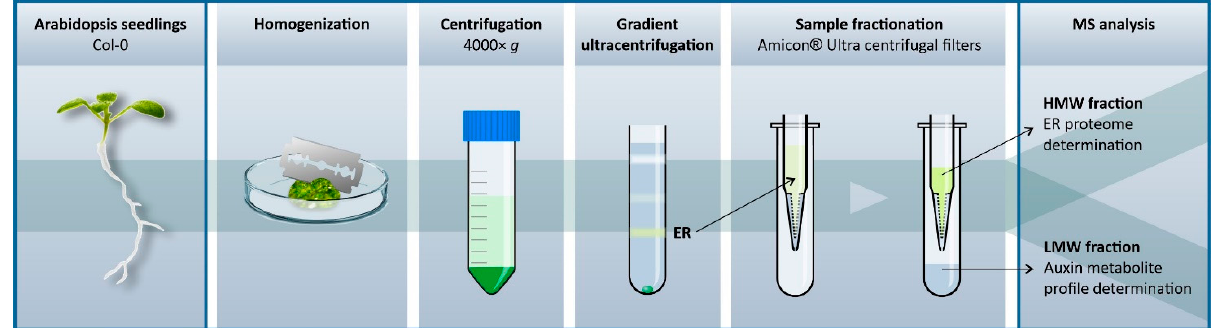
Figure 2. ER isolation workflow. 10-day-old Arabidopsis seedlings were placed in a Petri dish on ice and finely chopped with a razor blade in 2 mL of ice-cold homogenisation buffer. The resulting homogenate was filtered through two layers of Miracloth into a 50 mL tube and centrifuged at 4000× g and 4 °C for 10 min. Organelles in the resulting supernatant were fractionated using a discontinuous sucrose density gradient. The ER-enriched fraction was then passed through Amicon ® Ultra centrifugal filters (cut-off: 3kDa) to obtain a high-molecular weight (HMW) fraction containing proteins and a low-molecular weight (LMW) fraction for auxin metabolite determination by liquid chromatography coupled with tandem mass spectrometry.